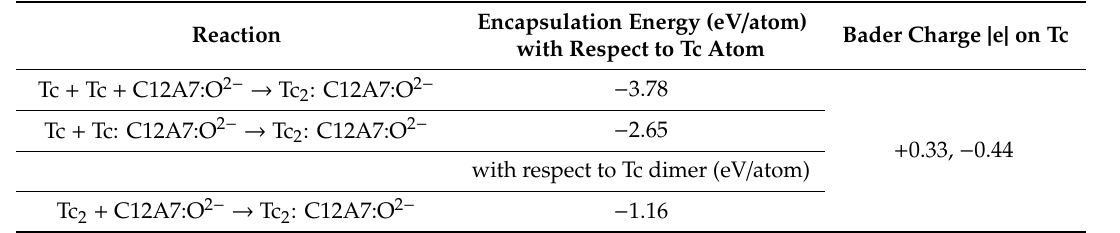
Table 3. Encapsulation energy and Bader charge calculated for the formation of a Tc dimer inside C12A7:O 2 −